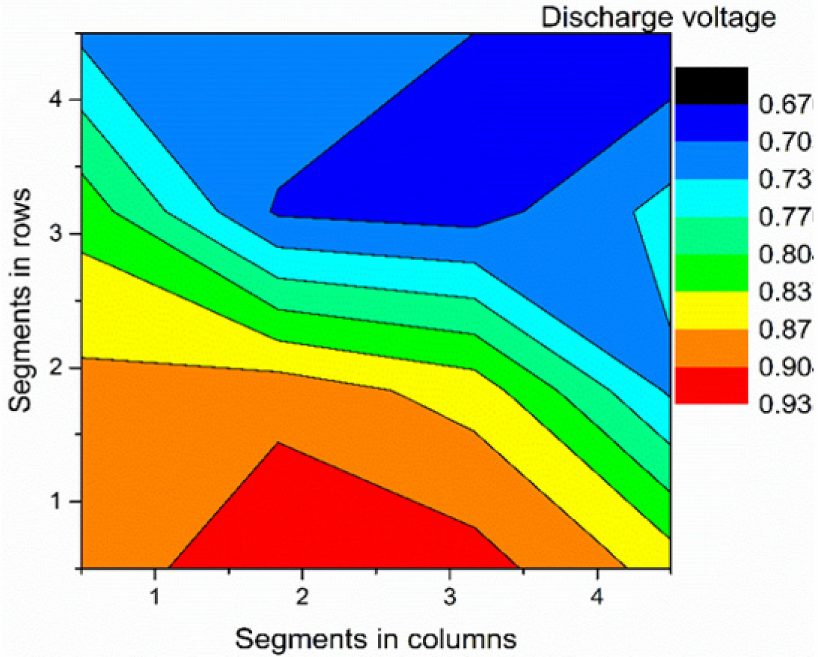
Figure 12. Contour diagram of discharge voltage (flow direction from bottom to